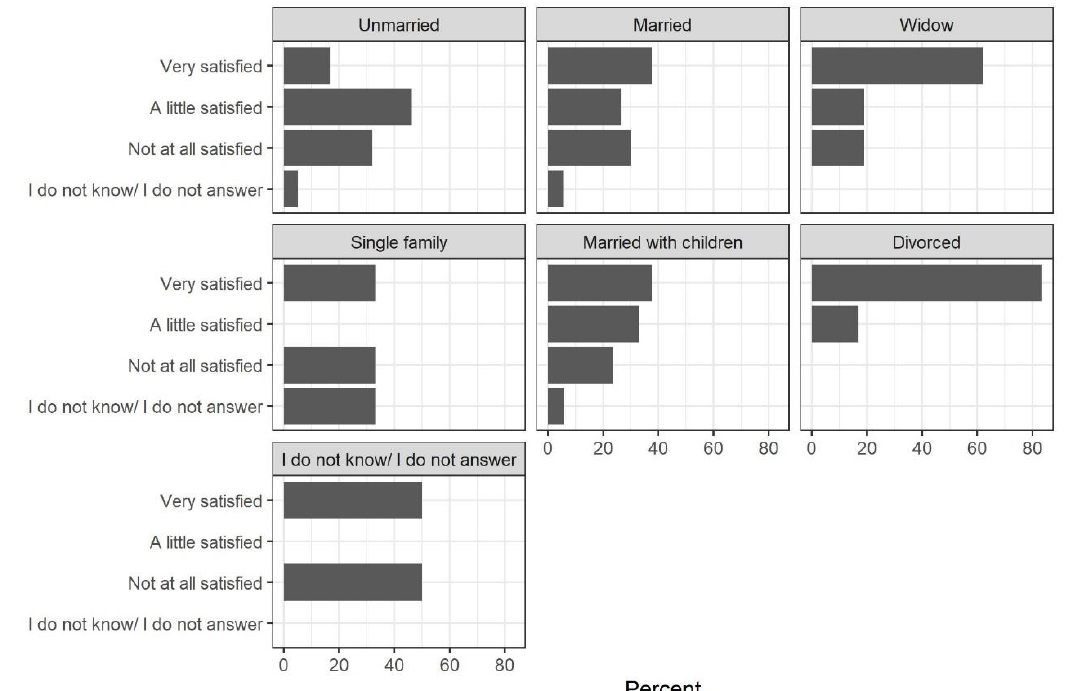
Figure A6. Cross-tabulation of attitudes of believers about the reaction of the Church by marital status (% by marital status). Χ 2 = 37.37, df = NA, p = 0.008 (Pearson’s Chi-squared test with simulated p -value based on 2000 replicates).